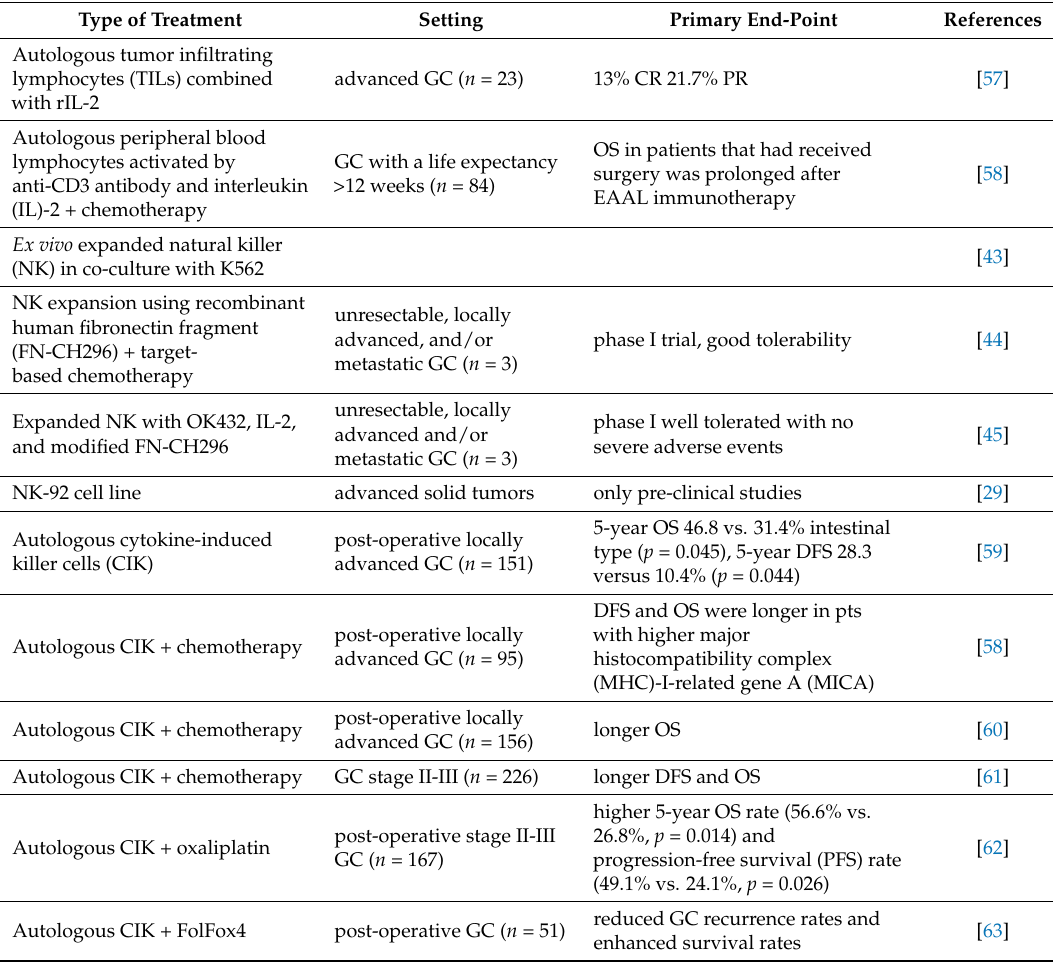
Table 2. Adoptive cell immunotherapy for gastric carcinoma